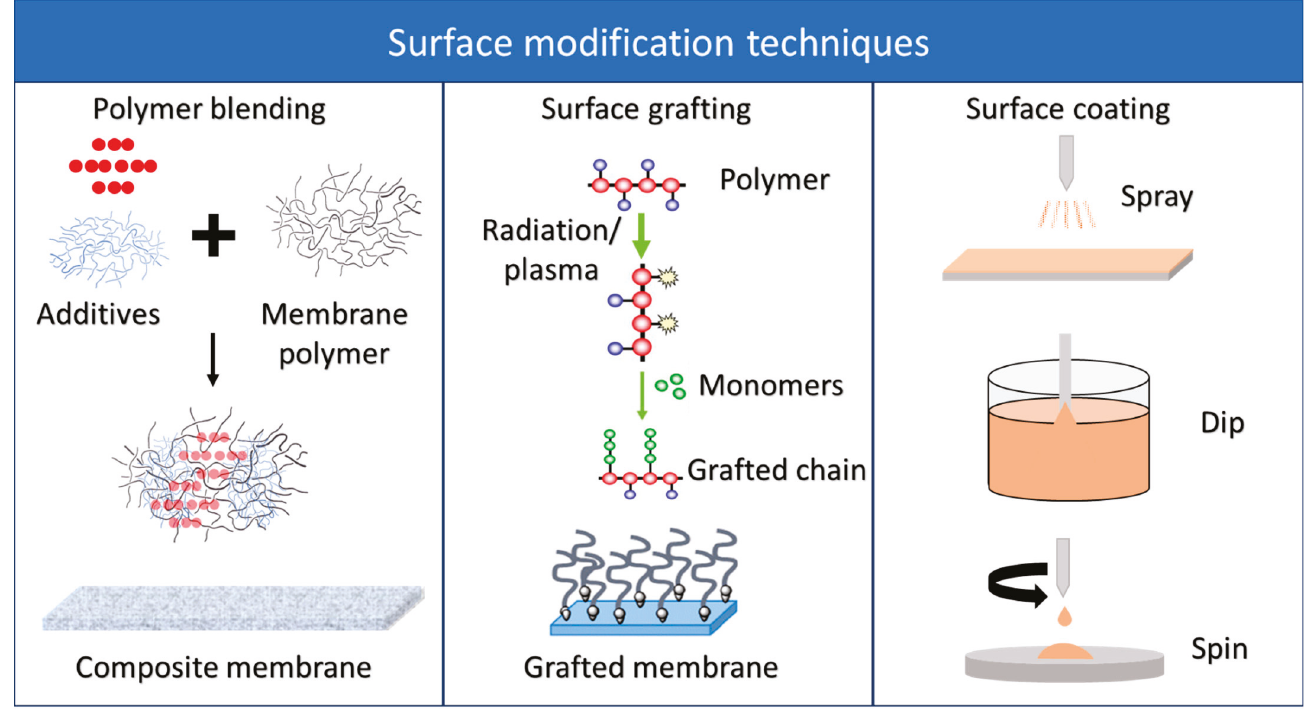
Figure 4. Membrane surface modification techniques. Table 6. Surface modification techniques.